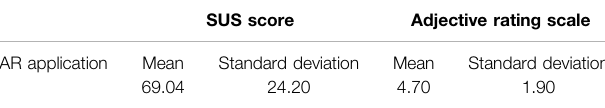
TABLE 3 | Average SUS scores and adjective rating scale of the AR